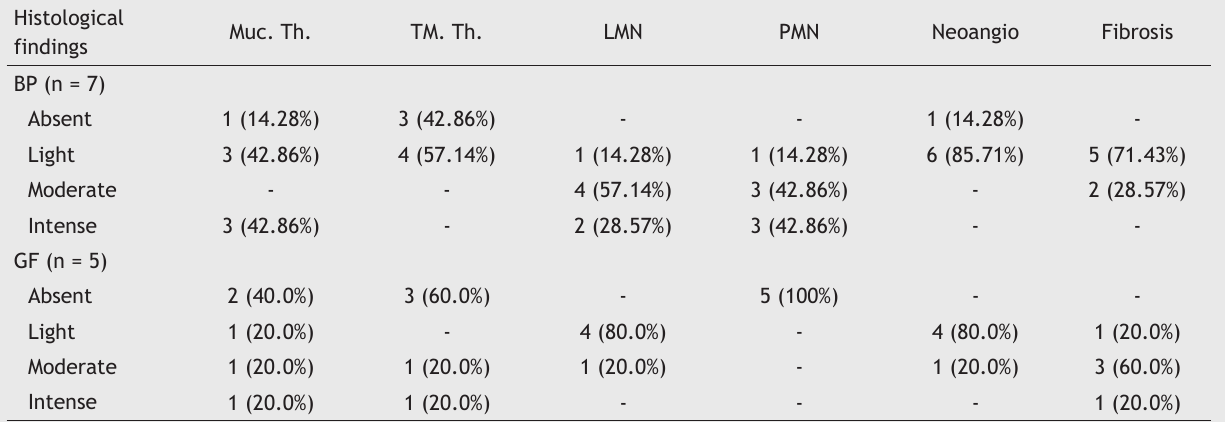
Table 1 Histological findings in the tympanic bulla of rats after one month of the experiment (T1). Histological findings